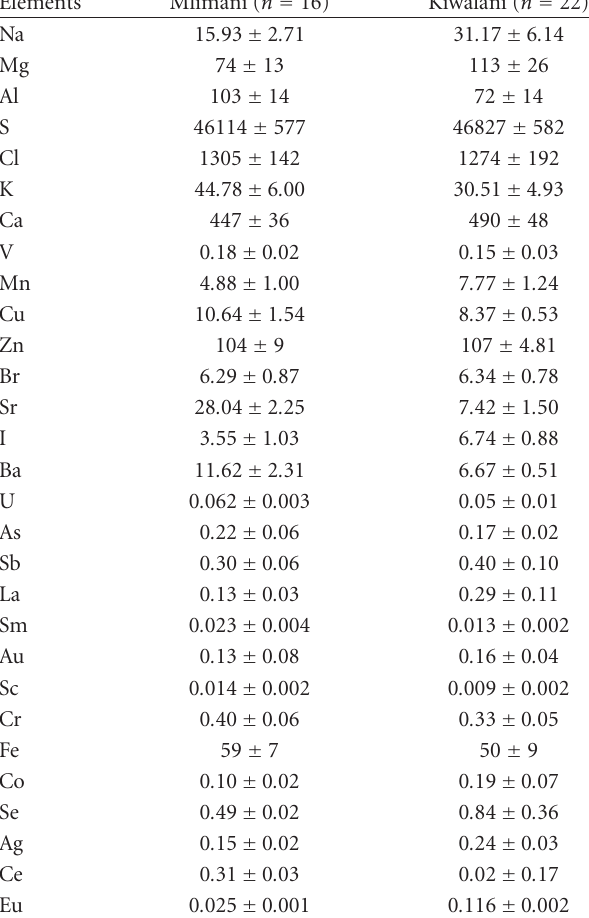
Table 2: The concentration of elements in µ g/g (mean ± Std. error mean) found in hair children living in Dar es